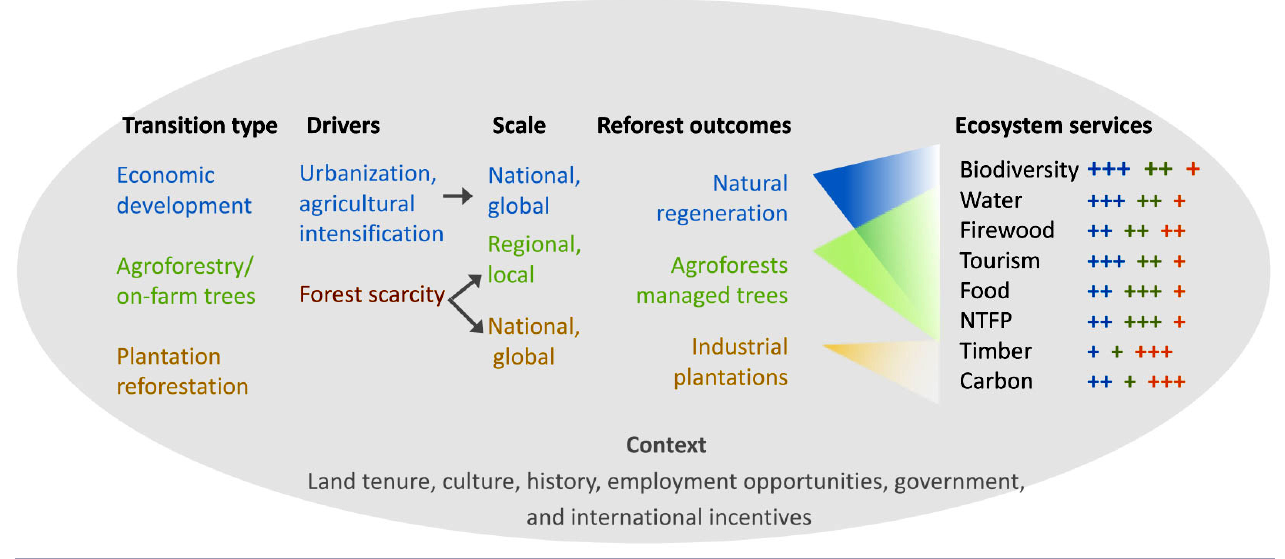
Fig. 2 . The three forest transition pathways, their drivers, and their relative ecological outcomes. Note: The final column represents the potential amount of each service that would be expected to return during a transition, relative to the other transition types. (NTFP: nontimber forest